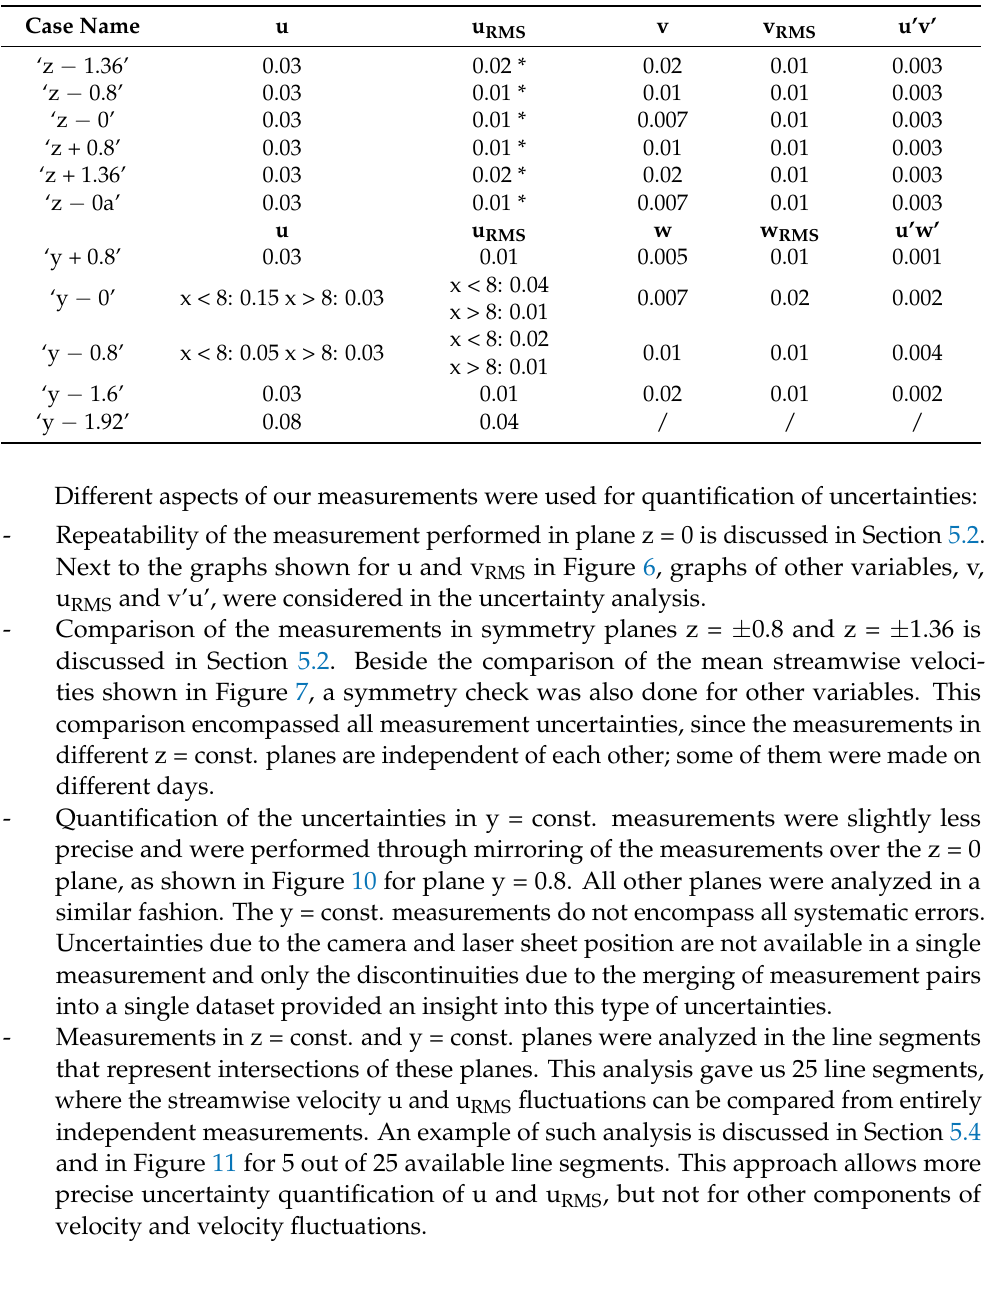
Table 2. Absolute uncertainties of measured quantities rounded to the leading digit (* uncertainties up to 0.05 are present in the interval 0 < x < 3 where maximum u RMS values are measured and